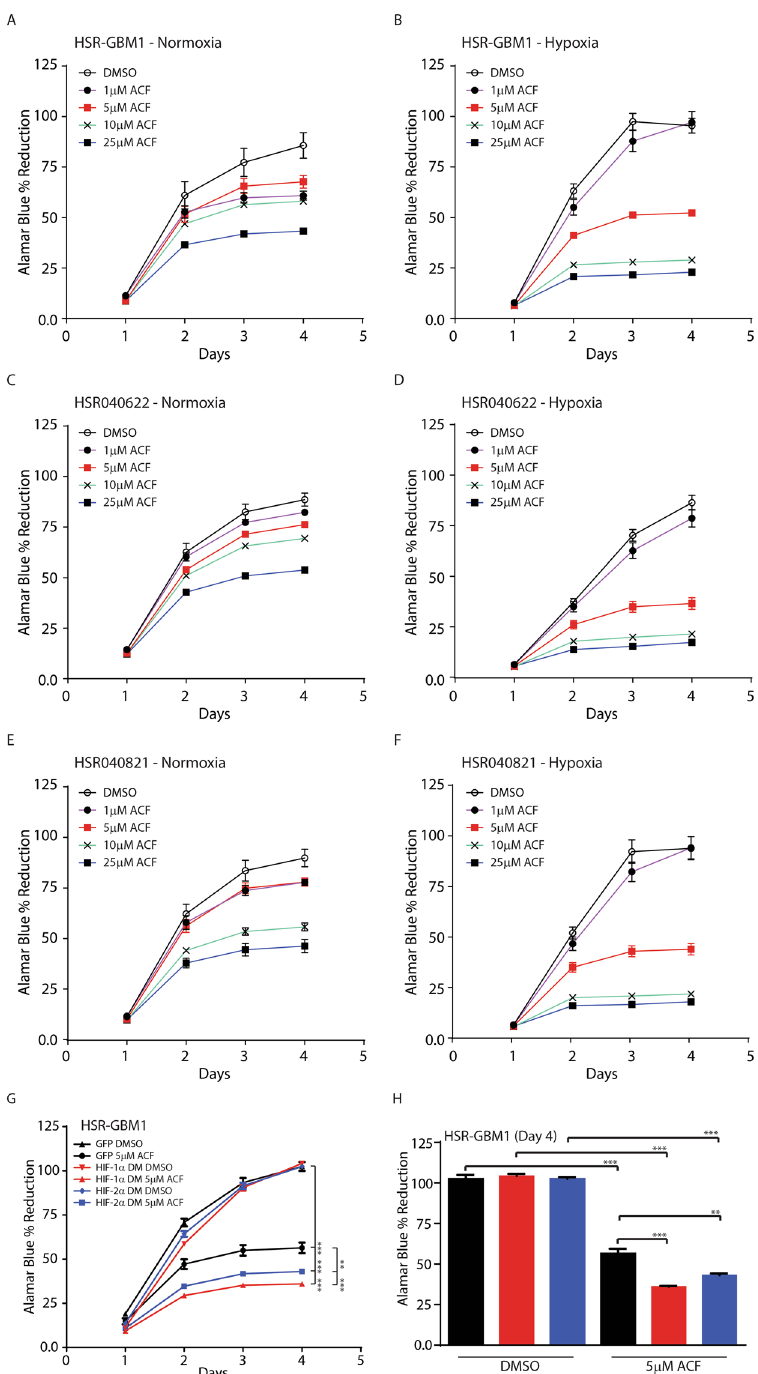
Figure 3. ACF inhibits GSC growth in a dose-dependent fashion, and its anti-growth effect is augmented by hypoxia or by expression of, double-mutant, oxygen stable, forms of HIF-1 α or HIF-2 α . Growth curves of HSR-GBM1 ( A , B ), HSR040622 ( B , C ), and HSR040821 ( E , F ) treated with 0 (DMSO), 1, 5, 10, and 25 μ M ACF in normoxia (21% oxygen; A , C , E ) and hypoxia (1% oxygen; B , D , F ). ( G , H ) Growth curve for HSR-GBM1 GSCs expressing GFP (as control) or the oxygen stable, double mutant (DM), forms of HIF-1 α or HIF-2 α , and treated with ACF at 0 (DMSO), 1 μ M or 5 μ M significantly reduced cell growth over a four-day period in normoxia. (H) A bar-graph analysis of day 4 time point is shown in ( G ). ( *** p < 0.001, ** p < 0.01; One way ANOVA with multiple comparisons; Mean + / − SEM of triplicates is shown in all